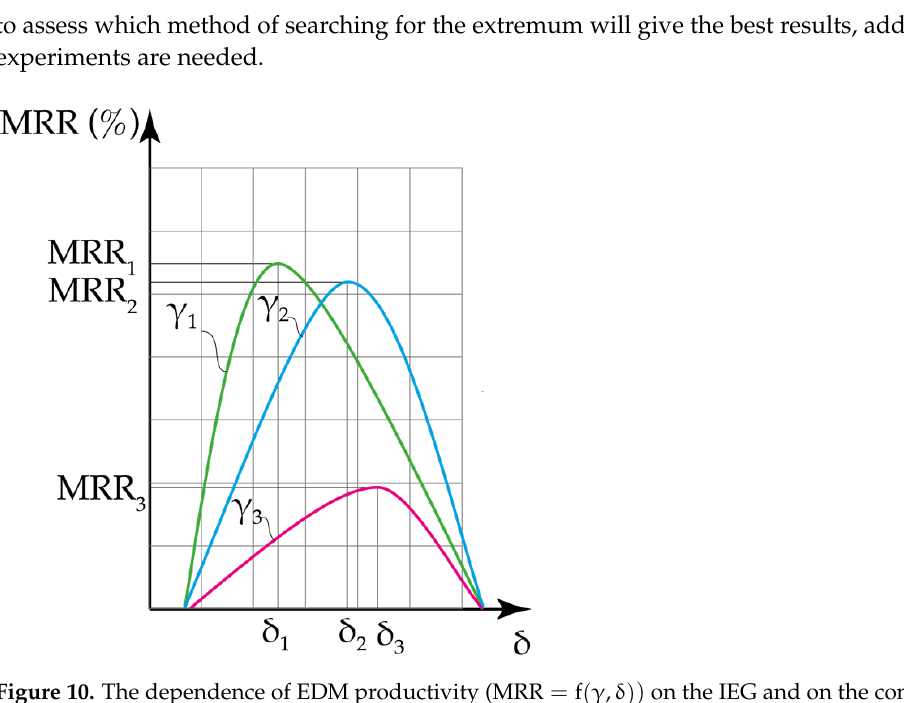
Figure 10. The dependence of EDM productivity (MRR = f ( γ , δ )) on the IEG and on the concentra- tion of contaminants ( γ 1 < γ 2 < γ 3 ).